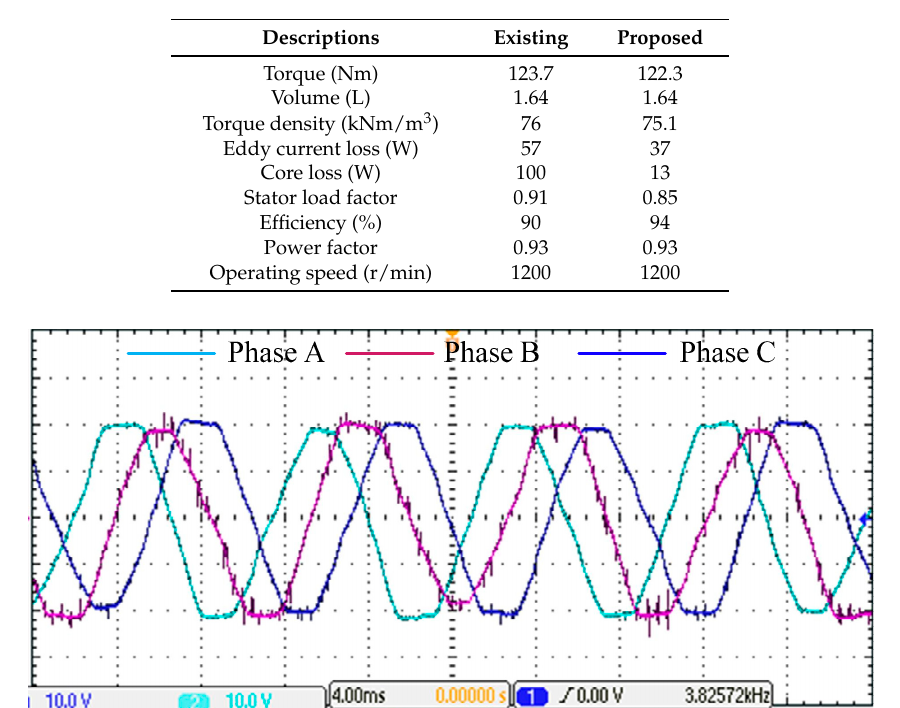
Figure 16. Measured back-EMF waveforms (4 ms/div, 10 V/div): the green line marks phase A, the red line marks phase B and the blue line marks phase C.